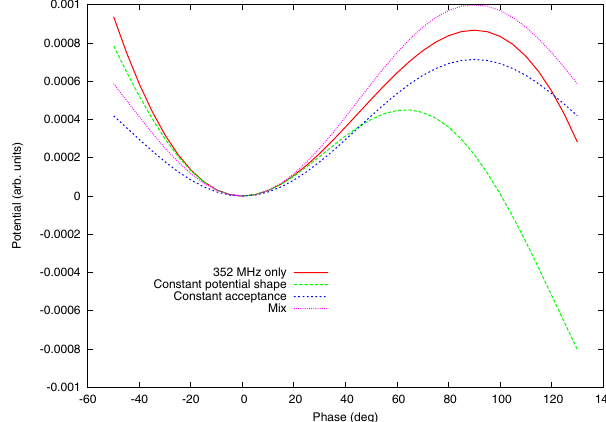
FIG. 4. (Color) The potential well shape for the three different techniques for an initial synchronous phase of (cid:1) 45 degrees .